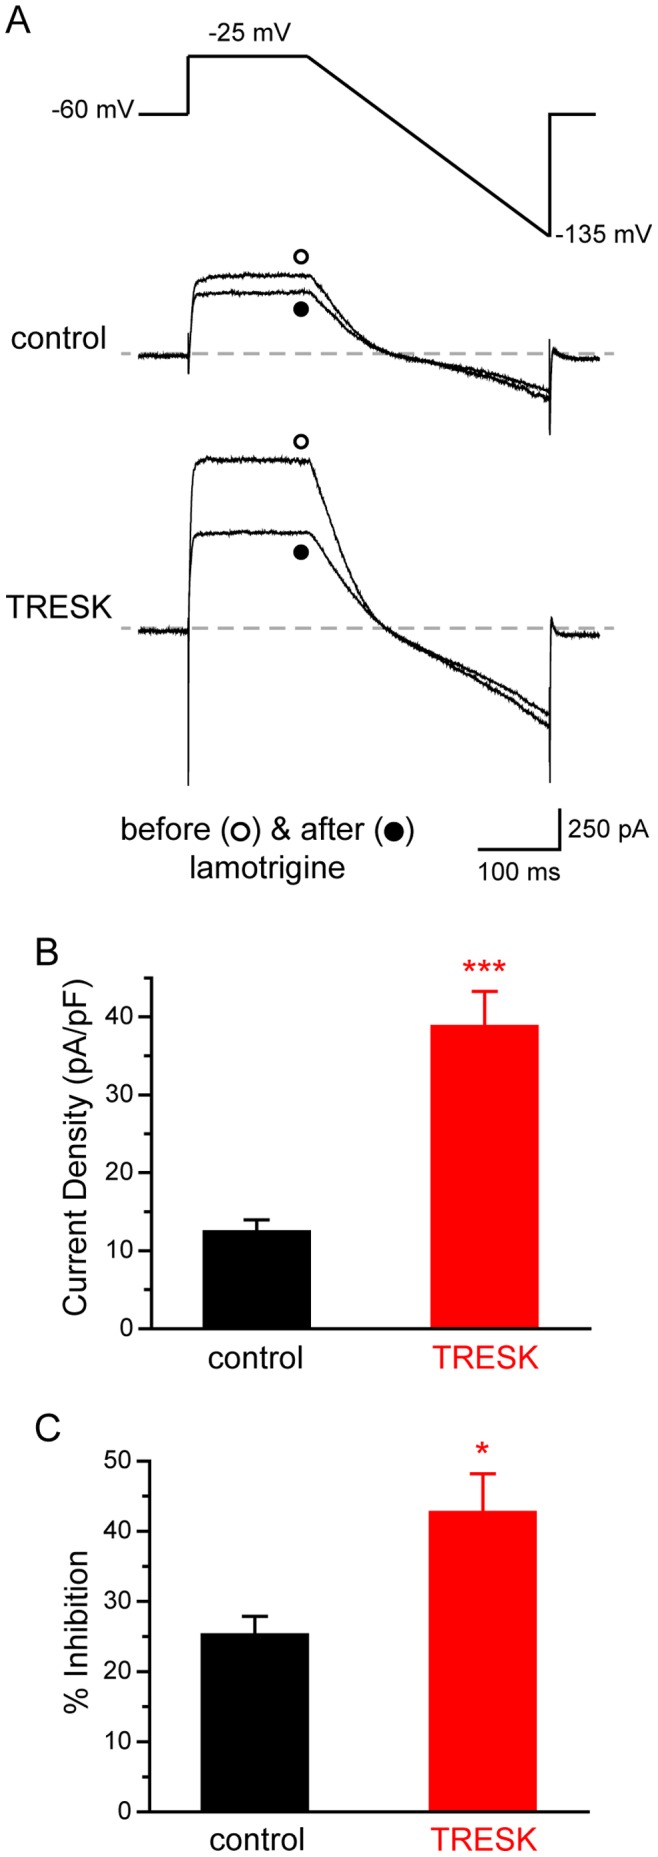
Over-expression of TRESK subunits increases the background K+ currents in TG neurons.
A, Upper panel: the voltage protocol used to minimize transient voltage-gated K+, Na+ and Ca2+ currents. Middle and lower panels: representative current traces from TG neurons expressing mCherry (the control group) and mCherry-TRESK (the TRESK group) before and after the application of 30 µM lamotrigine, respectively. B, Mean total outward current density (measured at the end of the depolarizing step) in TG neurons expressing mCherry and mCherry-TRESK, respectively (*** p<0.001, two-tailed t-test, n = 22 and 21 cells in each group, respectively). C, The percentage of outward current (measured at the end of the depolarizing step) inhibited by lamotrigine in the control and TRESK groups, respectively (* p<0.05, two-tailed t-test, n = 17 and 11 cells in each group, respectively).